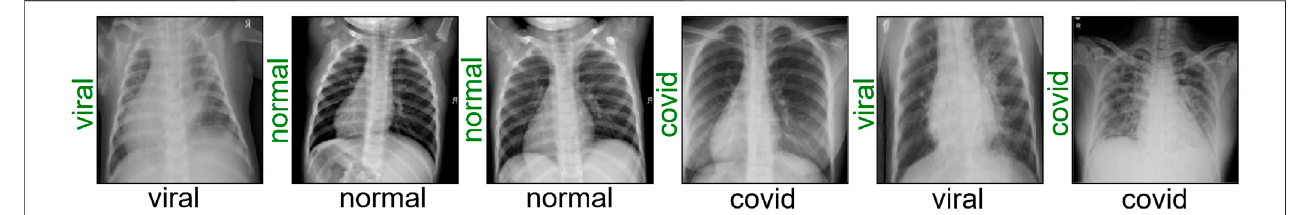
FIGURE 3 | Classi fi cation results of Resnet model. If the classi fi cation is correct, a green label will appear, otherwise a red label will appear. The Resnet model can correctly classify normal, viral pneumonia, and COVID-19 after training.